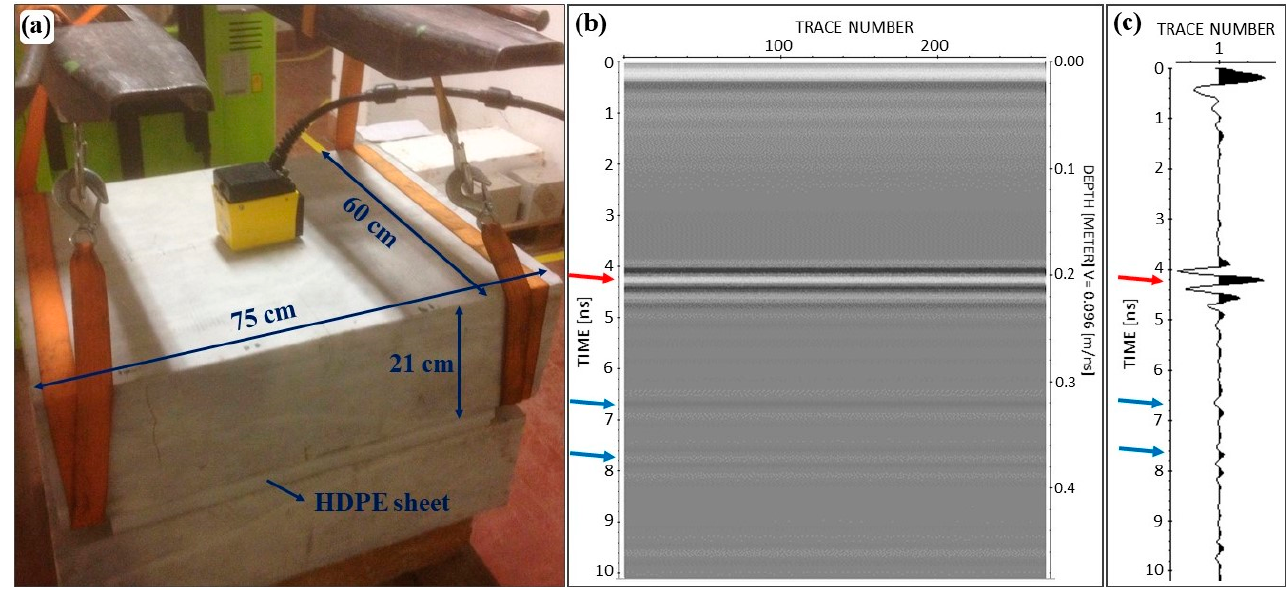
Figure 1. ( a ) Time-triggered GPR data acquisitions on two marble blocks separated with an HDPE layer. ( b ) The processed GPR data. ( c ) A single radar trace extracted from the processed GPR data.